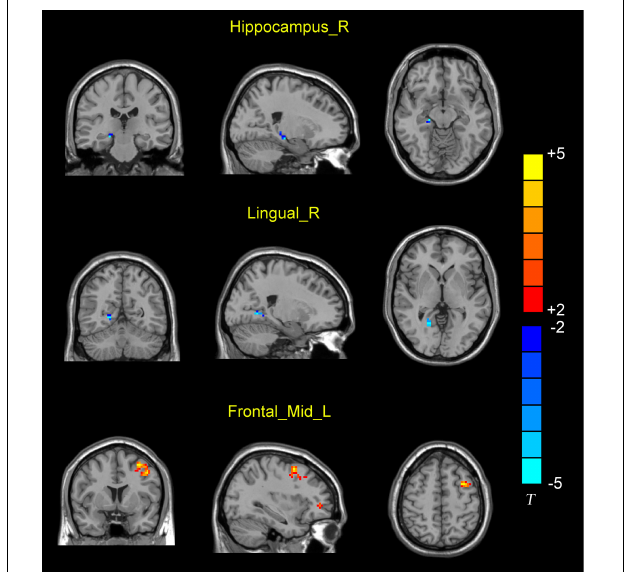
FIGURE 1 | Differences in DC value between CAD patients and HC. Blue represents the decreased DC values in the right hippocampus (hippocampus_R) and right lingual gyrus (lingual_R). Red represents increased DC values in the left middle frontal gyrus (Frontal_Mid_L).